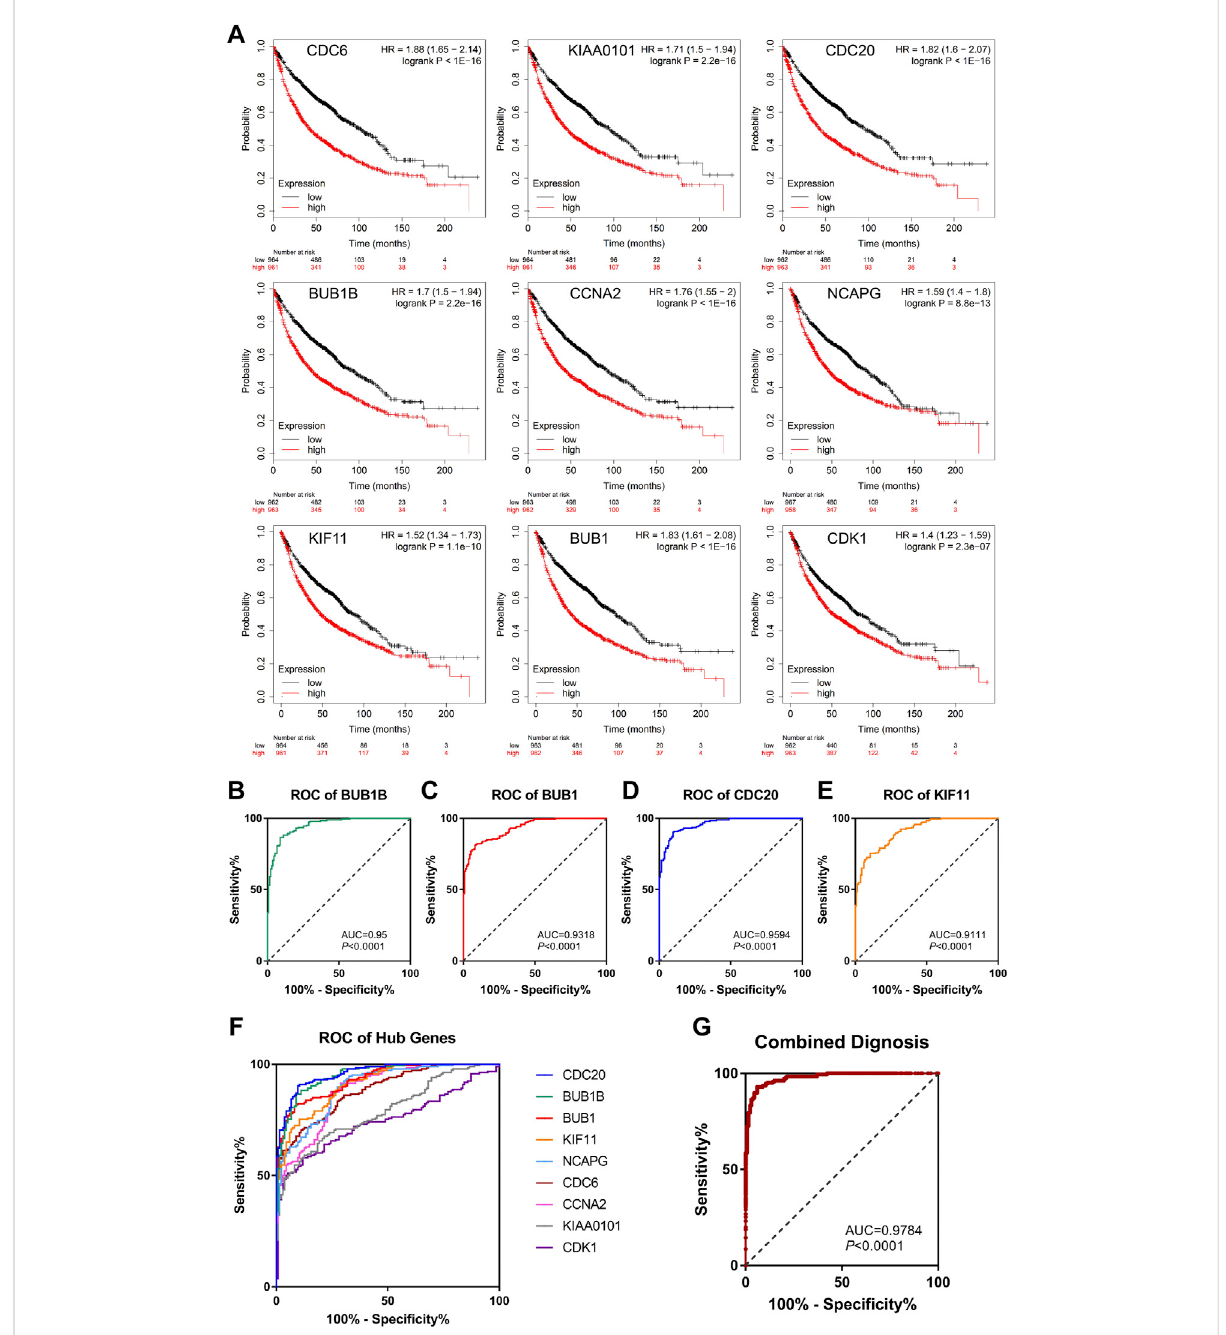
FIGURE 5 Survival analysis and ROC curve analysis of hub genes in NSCLC. (A) Kaplan-Meier survival curves of OS based on the hub genes (CDC6, KIAA0101, CDC20, BUB1B, CCNA2, NCAPG, KIF11, BUB1, CDK1) expression using the online bioinformatics tool Kaplan-Meier Plotter. (B – F) Individual ROC curve of hub genes according to the chip data of GSE19804, GSE43458 and GSE18842. (G) Combined ROC curve of hub genes according to the chip data of GSE19804, GSE43458 and